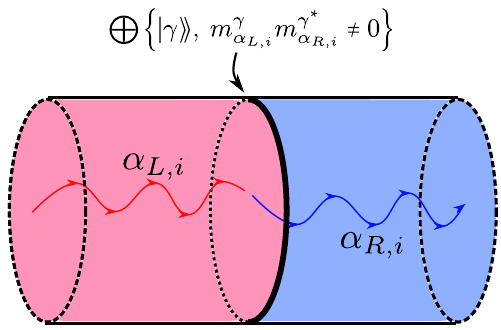
(cid:13) Figure 4 . Anyon (cid:11) (cid:13) when approaching the interface ; a similar branch- L;i branches into (cid:8) (cid:13) m (cid:11) L I i (cid:3) ing occurs for (cid:11) R;i . If they share a channel m (cid:13) m (cid:13) = 0 for some (cid:13) then this mediates (cid:11) L;i (cid:2) (cid:11) (cid:3) R;i 6 the transmutation of (cid:11) L;i to (cid:11) R;i across the interface. The e(cid:11)ective set of Ishibashi states for this interface are spanned by these branching